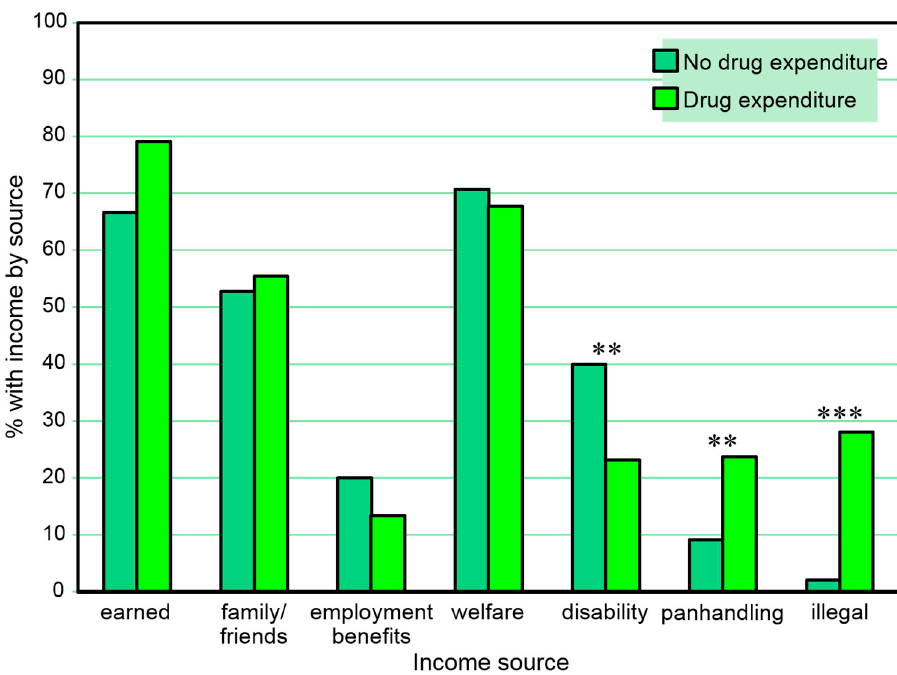
Figure 5. Proportions with any 30-day income sources among those with and without any 30-day drug expenditures across three interviews. ** p ≤ 0.01, *** p ≤ 0.001.